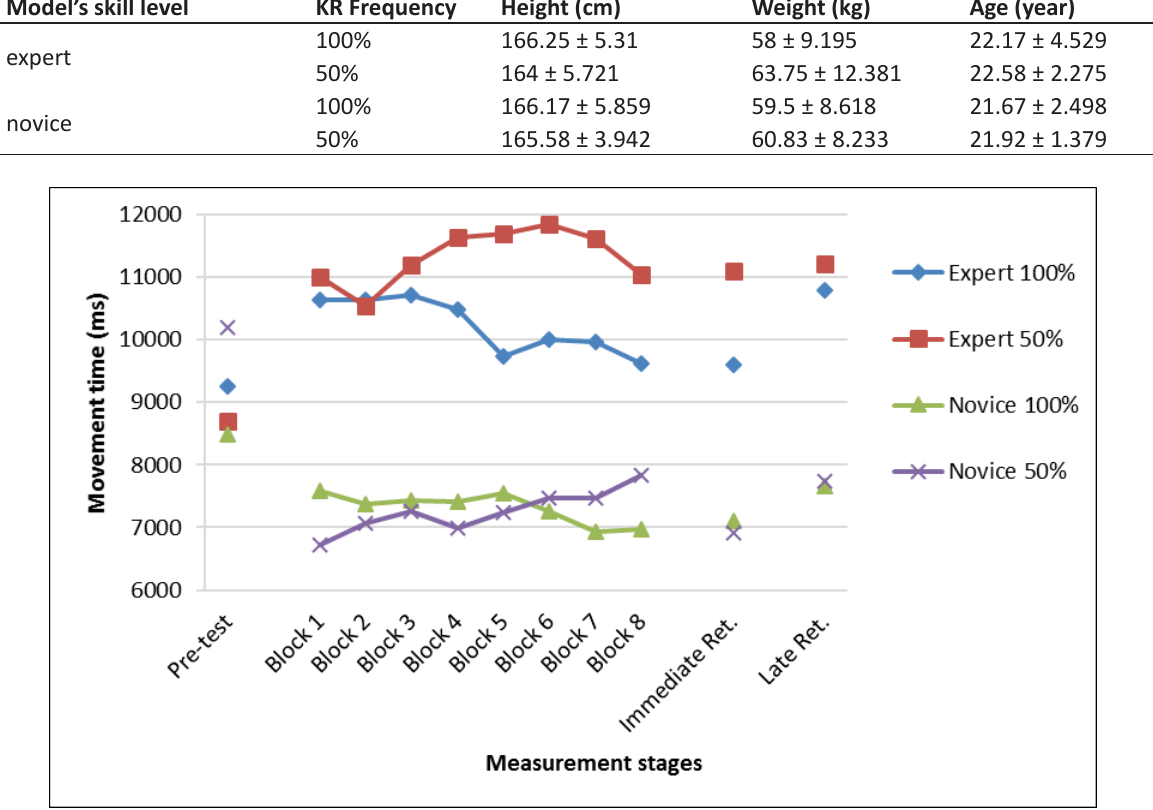
Table 1: Demographic characteristics of participants including height, weight, and age Model’s skill level